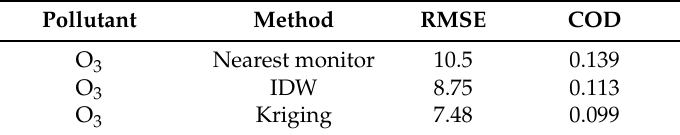
Table 3. Results from cross-validation data in this study.